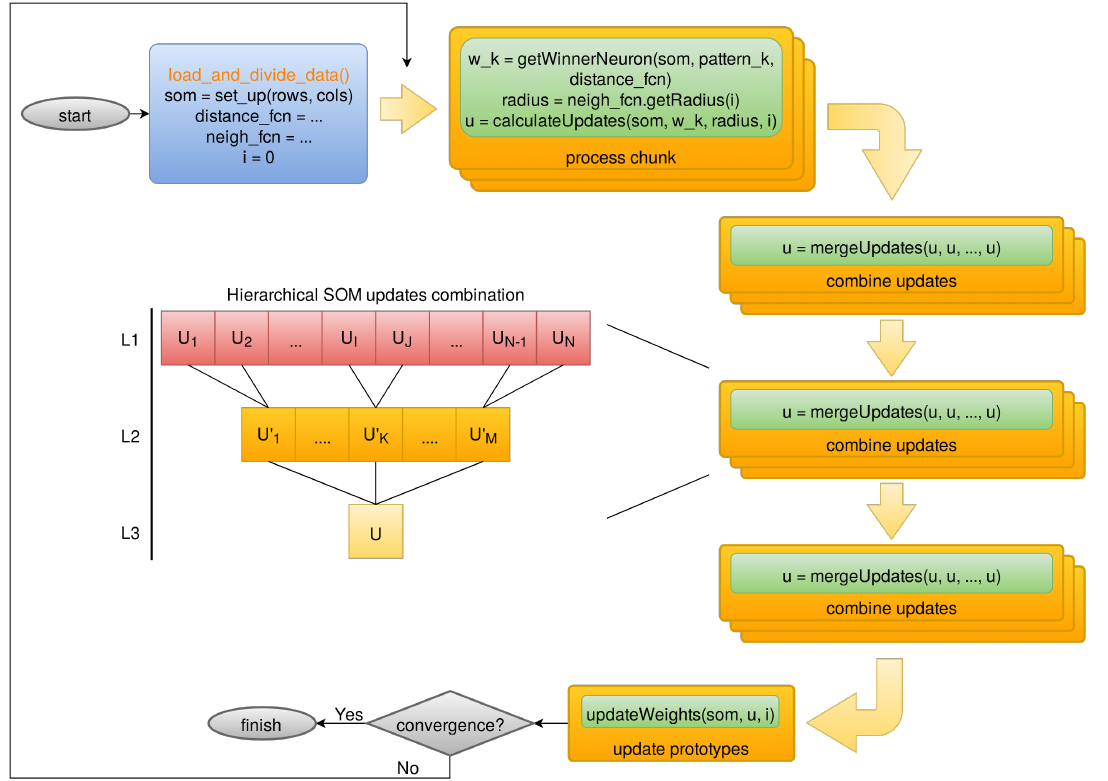
Figure 7. System of Accommodation of Gaia Algorithms (SAGA) facades design for Self-Organized Maps (SOM) that will run at the Centre National d'Études Spatiales